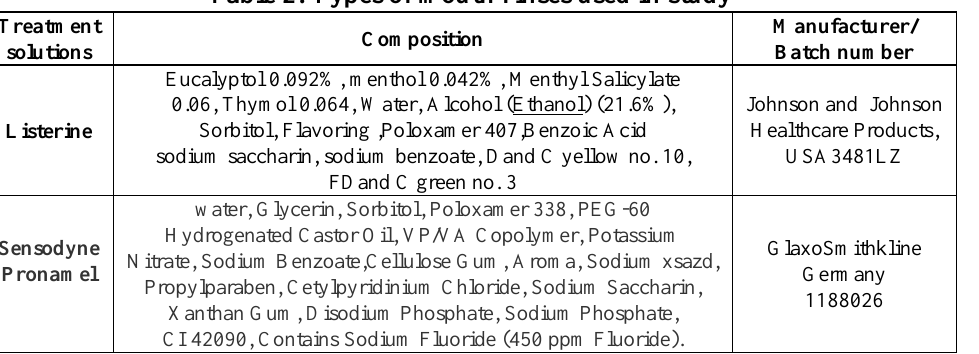
Table 2: Types of mouth rinses used in